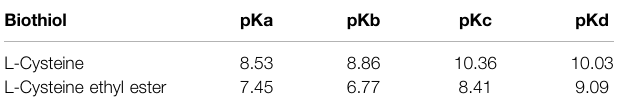
TABLE 3 | Macroscopic constants for each equilibrium ( K a – K d ) denoted in Figure 6 for L-cysteine and L-cysteine ethyl